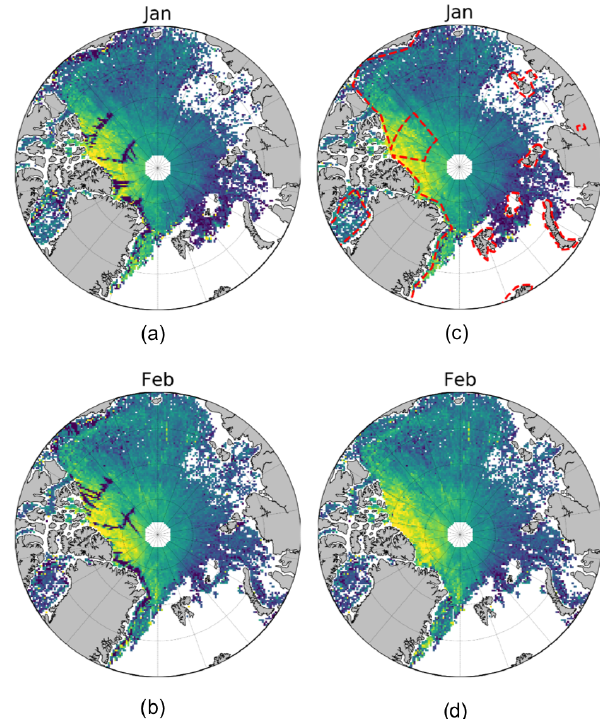
Figure 9. Illustration of the Baseline-D product improvements by comparison with in situ measurements. The first two panels com- pare the 2014 Operation IceBridge (OIB) freeboard measurements with (a) the Baseline-C and (b) the Baseline-D sea ice freeboard. The two following scatterplots compare the winter 2013/14 Beau- fort Gyre Exploration Project (BGEP) sea ice freeboard converted to draft estimations with (c) the Baseline-C and (d) the Baseline-D sea ice freeboards.